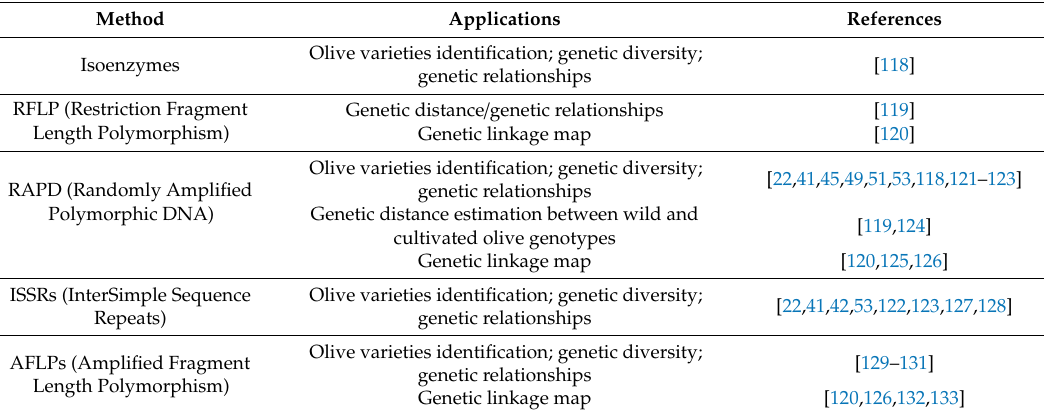
Table 3. Applications of some non-species-specific molecular markers in olive